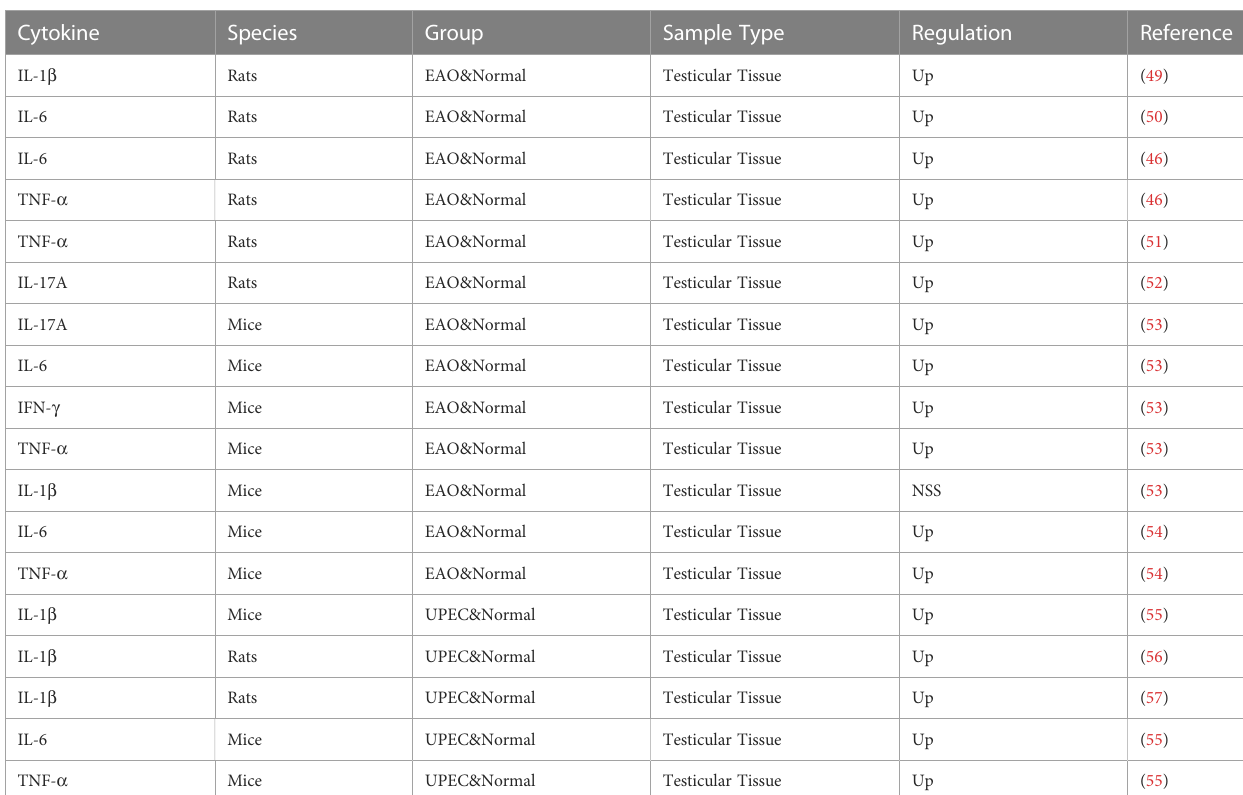
TABLE 2 Cytokines and